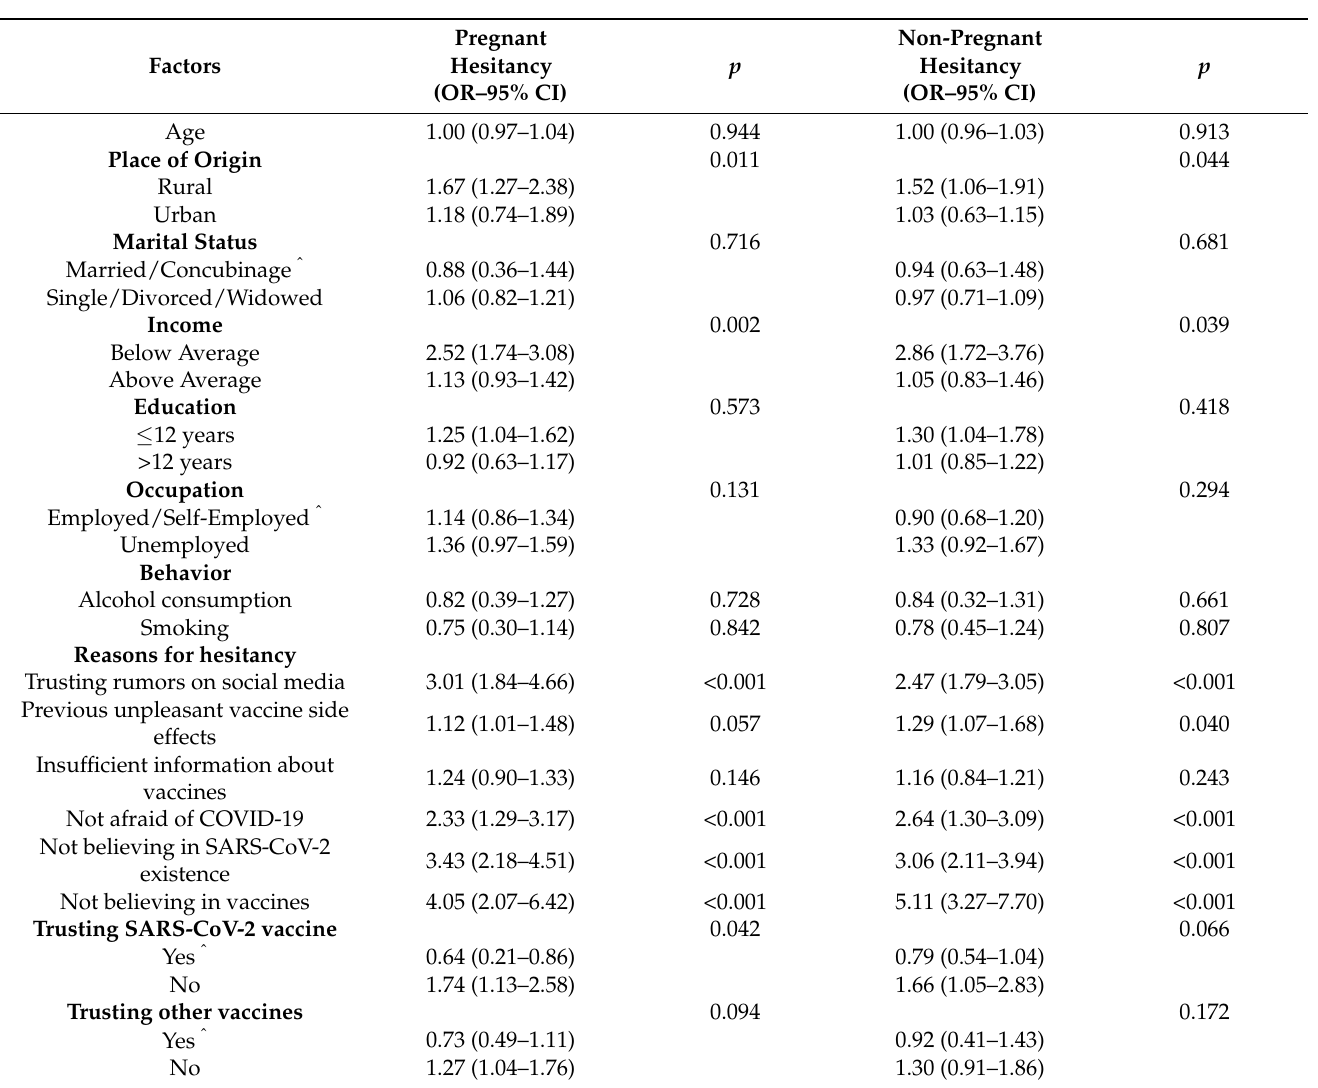
Table 4. Analysis of risk factors for general vaccination willingness of pregnant women against